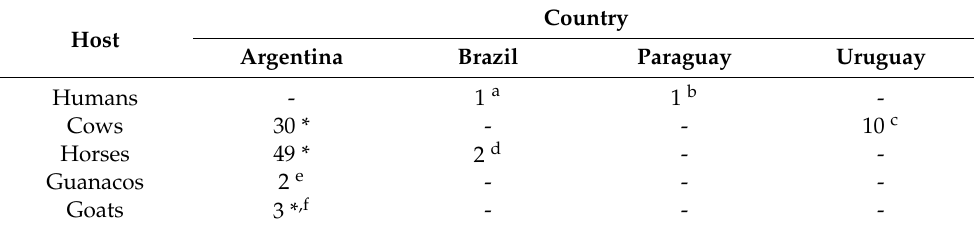
Table 1. Number of NSP4 E12 strains reported in South